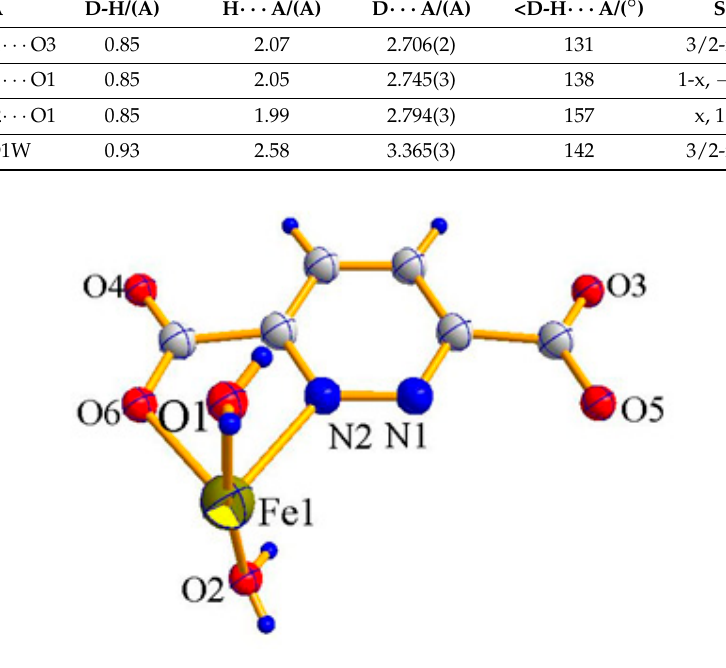
Figure 1 . Asymmetric unit of complex 1 .